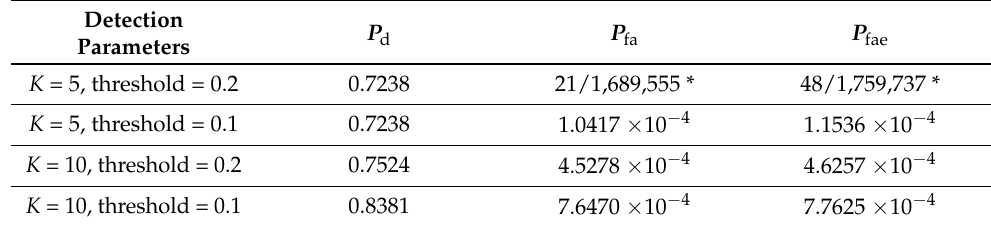
Table 4. P d and P f of the vessel with MMSI = 636014619 in a time interval of 1 h (18–19 h).